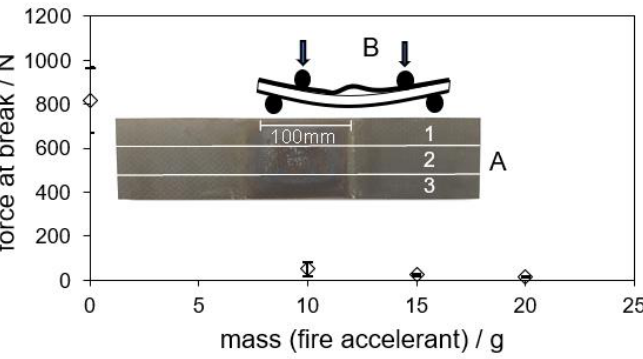
Figure 15. Force at break in a four-point bending test of sandwich panels made of the material M18-1/G939 after impact of various amounts of fire accelerant. Each data point represents the average of three tested specimen at position 1, 2, 3 ( A ) Sketch ( B ) represents typical failure mode with the thermally treated side on top.